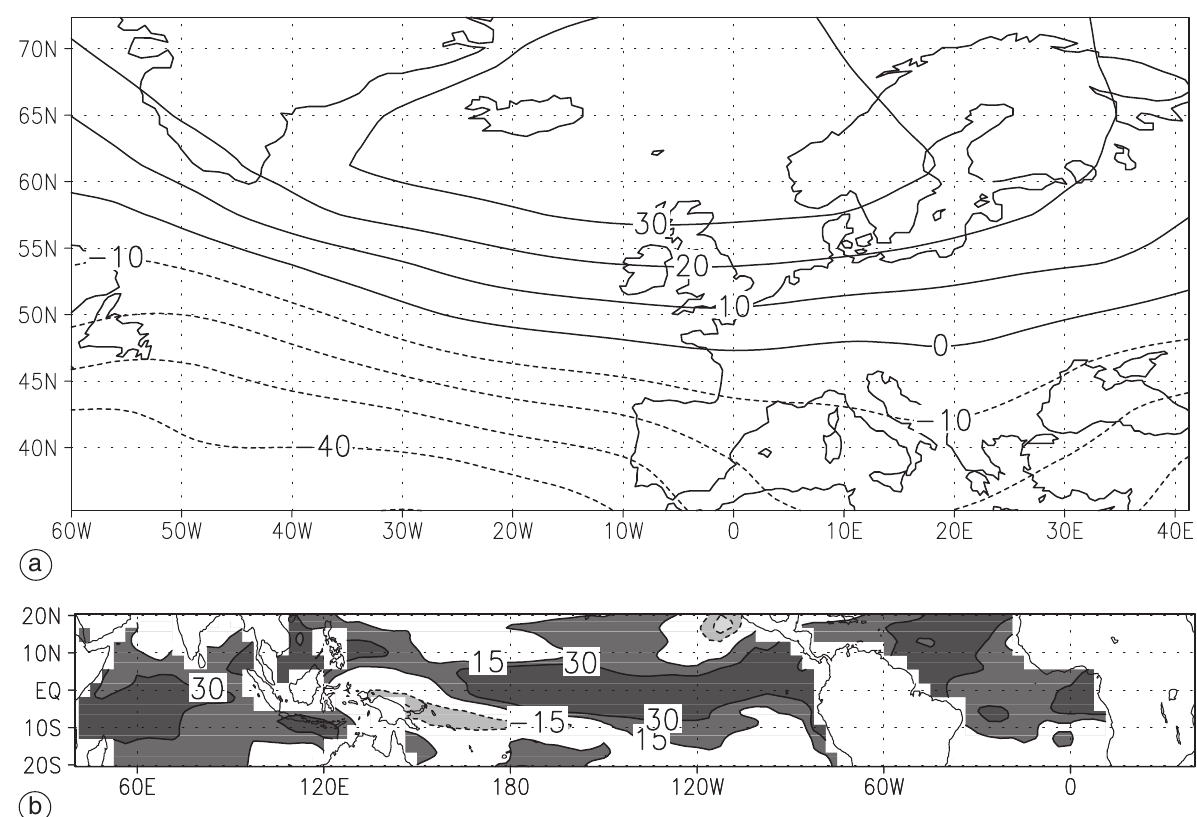
Fig. 5a,b. Leading pair of heterogeneous correlation patterns from an SVD analysis of 301 years of model simulated JFM seasonal mean tropical SST and JFM seasonal mean Atlantic/European MSLP. a) MSLP correlations (in %); b) SST correlations (in %). Squared covariance fraction = 84%. Total explained MSLP variance fraction in Atlantic/European region = 7%. Statistical significance level < 0.5%.